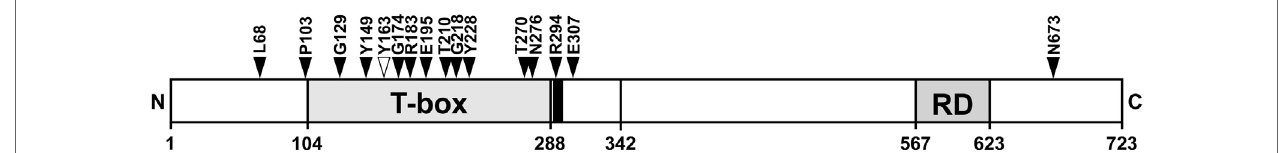
FigUre 7 | Position of TBX3 frameshift mutations in breast cancer . The position of 16 somatic frameshift mutations identified in primary breast cancer tumors is indicated on a schematic drawing of TBX3 [723 amino acids (aa)]. The positions of the T-box, the nuclear localization sequence [290–295 aa, black bar adjacent to T-box (35)], and the C-terminal repression domain (35) are shown as gray boxes. Fifteen of 16 mutations cluster in the N-terminal half of the protein, most of them in the T-box.